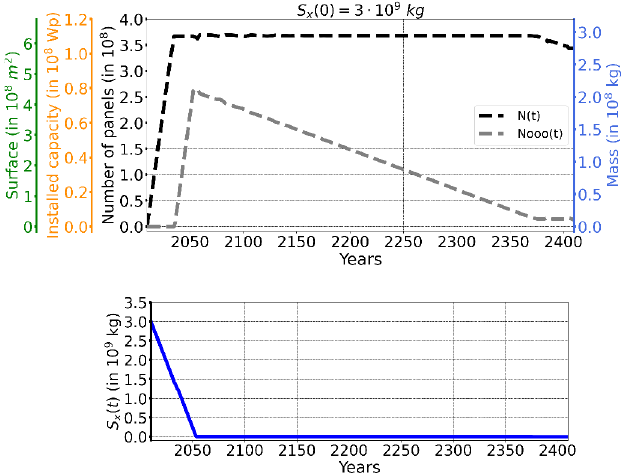
Fig. 10. Number of panels (up part), produced (dashed black line) and out of order panels (dashed gray line) following scenario C with t f = 400 years) and S x (0) = 3 billion kilograms. Raw material stock as a function of time (bottom part, blue line). Highlighting of the two steps leading to scarcity effect after 370 years.